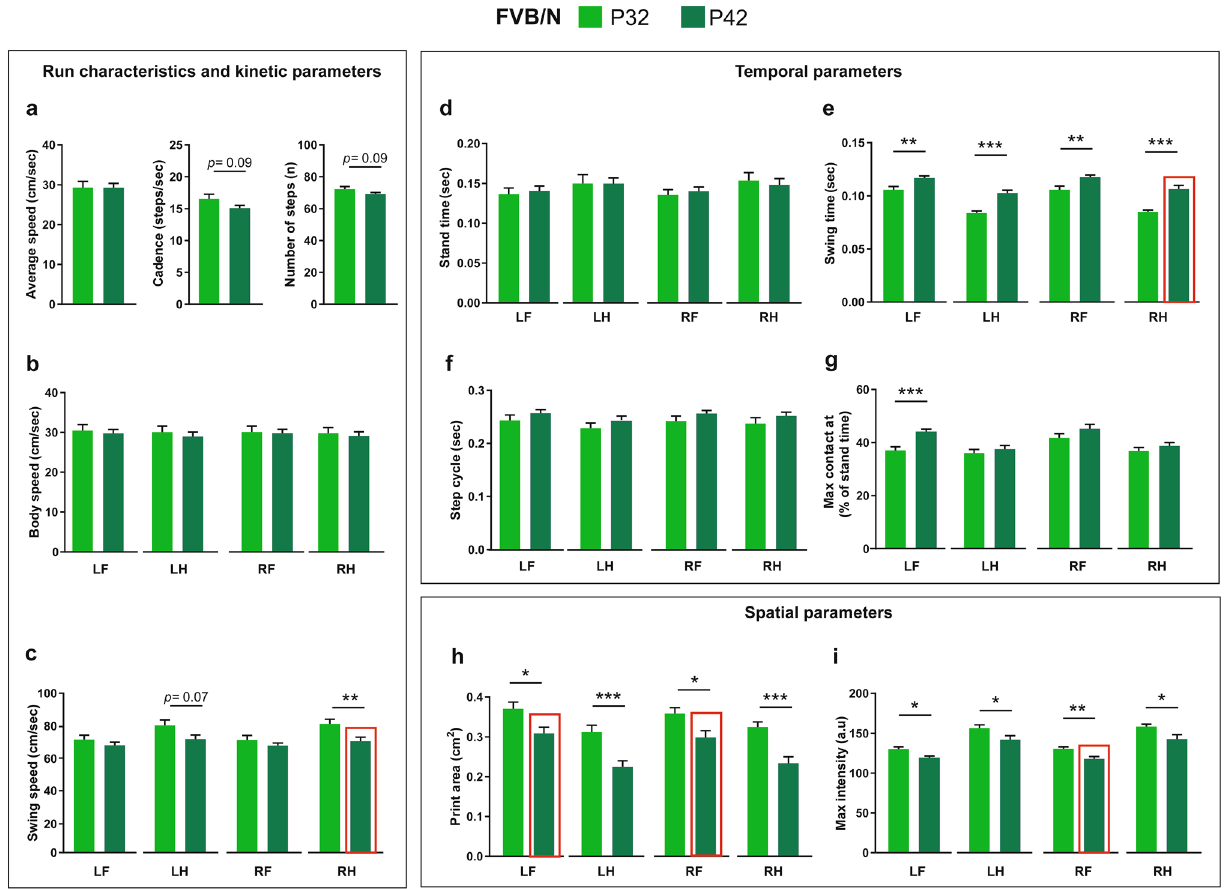
Figure 6. Comparison of run characteristics and kinetic, temporal and spatial parameters between P32 and P42 FVB/N mice. ( a , b ) No differences were seen in the average speed, cadence, number of steps ( a ) or body speed ( b ) between P32 and P42 FVB/N mice. ( c ) The swing speed of the RH paw was significantly less at P42 than P32. ( d ) No difference was seen in the stand time between P32 and P42 FVB/N mice. ( e ) The swing time of all paws at P42 was longer than at P32. ( f ) No difference was seen in the step cycle between P32 and P42 FVB/N mice. ( g ) The maximum contact at (%) of the LF paw was significantly higher at P42 than at P32. ( h , i ) The print area ( h ) and the maximum intensity ( i ) at P42 were lower than at P32. Two-way ANOVA followed by Bonferroni post hoc test, * p ≤ 0.05, ** p ≤ 0.01, *** p ≤ 0.001. A red rectangle indicates a significant difference between sexes within a strain (see Supplementary Table S1). Error bars indicate the standard error of the mean (SEM). RF right front, LF left front, RH right hind, LH left